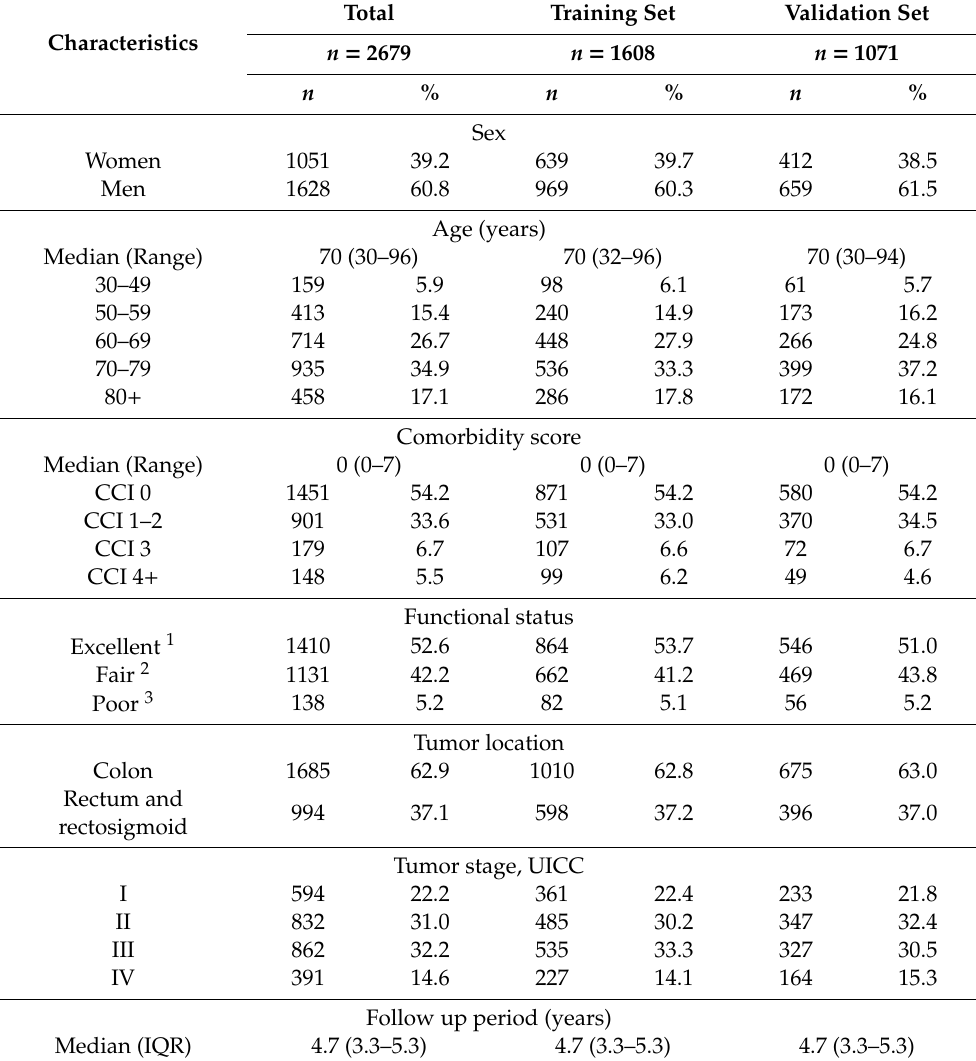
Table 1. Characteristics of colorectal cancer patients in both training and validation